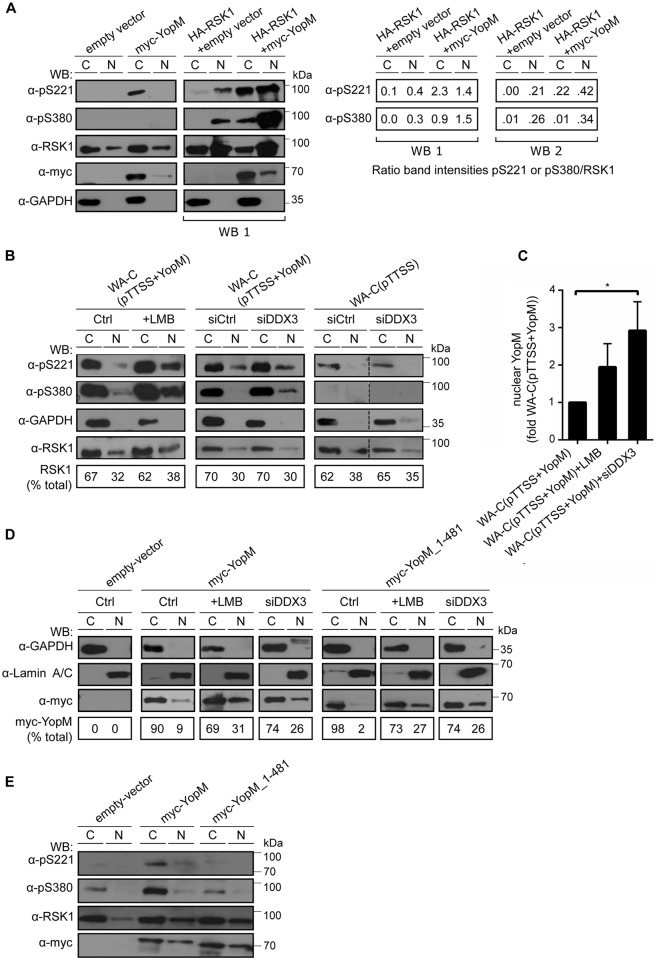
Nuclear YopM controls phosphorylation of nuclear RSK1.
A) Coexpression of HA-RSK1 and myc-YopM increases phosphorylation of nuclear RSK1. (Left panel) HEK293T cells were transfected with indicated expression vectors and cytosolic- (C) and nuclear (N) fractions were investigated by immunoblot using indicated antibodies. Anti-pS221- and Anti-pS380 antibodies detect the respective phosphorylated amino acids in RSK1. Exposure time of the anti-RSK1 panel in the HA-RSK1 expressing cells (right, WB 1) is about 1/5 of that of the respective panel in control cells (left). (Right panel) Intensities of the pS221- pS380- and RSK1 protein bands from WB 1 and WB 2, the latter derived from a second identical experiment were quantified and intensity ratios of pS221/RSK1 and pS380/RSK1 were calculated. B) Leptomycin B treatment and DDX3 knockdown increase phosphorylation of nuclear RSK1. (Left panel) HEK293T cells were not treated (Ctrl) or treated with 25 nM LMB for 4 h. (middle and right panels) HEK293T cells were treated with control siRNA (siCtrl) or DDX3 siRNA (siRNA No. 3) for 24 h. Cells were infected with Yersinia WA-C(pTTSS+YopM) (middle panel) or WA-C(pTTSS) (right panel) for 90 min and cytosolic- (C) and nuclear (N) fractions were investigated by immunoblot using indicated antibodies. Bottom panel shows percentage of total RSK1 present in the C- and N fraction of cells in each condition. C) Leptomycin B treatment and DDX3 knockdown increases nuclear YopM. HEK293T cells were not treated or treated with 25 nM LMB for 4 h or DDX3 siRNA (No. 3) for 24 h, infected with Yersinia WA-C(pTTSS+YopM) for 90 min and nuclear fractions of cells were investigated by anti-YopM immunoblot. Band intensities of YopM signals were determined by ImageJ. Each bar represents mean ± SEM of values from 4 experiments for LMB treatment and 3 experiments for DDX3 siRNA treatment; *p<0.05 (Bonferroni's multiple comparisons test). D) YopM_1–481 mutant defective in interaction with RSK accumulates in the nucleus and is exported from the nucleus in a LMB- and DDX3 dependent fashion. HEK293T cells were not treated (Ctrl), treated with 25 nM LMB for 4 h or DDX3 siRNA (siRNA No. 3) for 24 h and transfected with indicated expression vectors. Cytosolic- (C) and nuclear (N) fractions of cells in each condition were investigated by immunoblot using indicated antibodies. Bottom panel shows percentage of total myc-YopM present in the C- and N fraction of cells in the respective condition. See also S4 Fig for immunoprecipitaton of myc-YopM; myc-YopM_1–481 and myc-YopM_34–481 to verify the incapability of YopM lacking the C-terminus to bind RSK. E) YopM_1–481 mutant is unable to stimulate phosphorylation of RSK. Indicated myc-YopM constructs or empty vector were expressed in HEK293T cells and cytosolic (C) or nuclear (N) fractions were analyzed by Western blot using indicated antibodies.